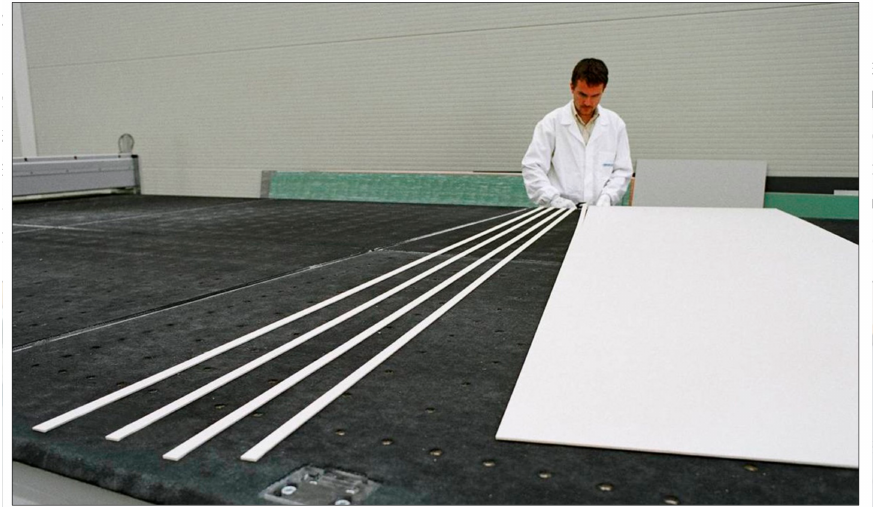
Figure 2. Ceramic “Lammax” slabs in the